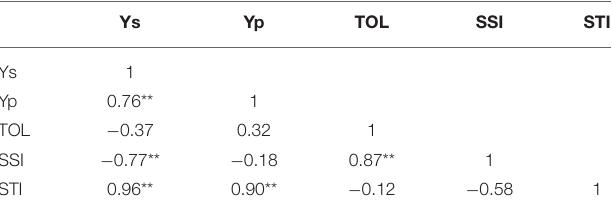
TABLE 6 | Correlations among average yield in waterlogging (Ys) and normal (Yp) conditions, tolerance (TOL), stress susceptibility index (SSI), and stress tolerance index